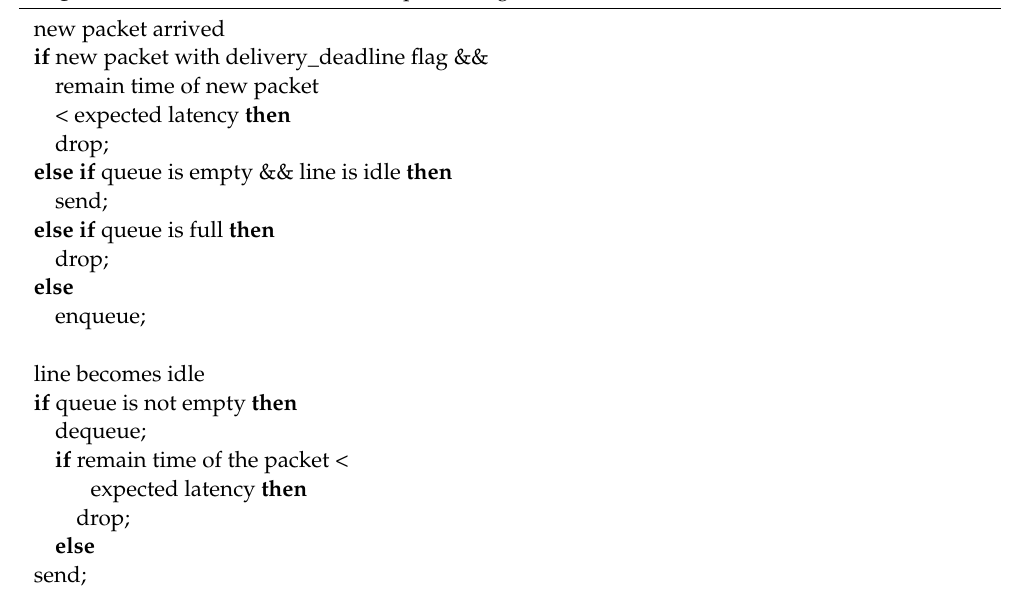
Algorithm 3: Best effort service class processing